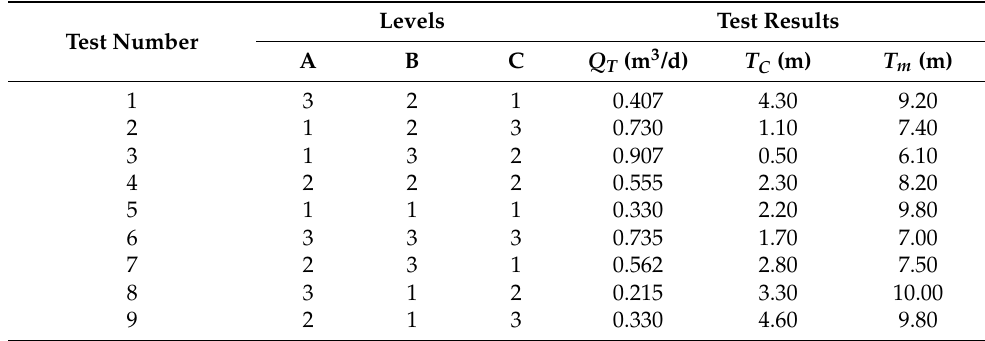
Table 6. Orthogonal experimental design and